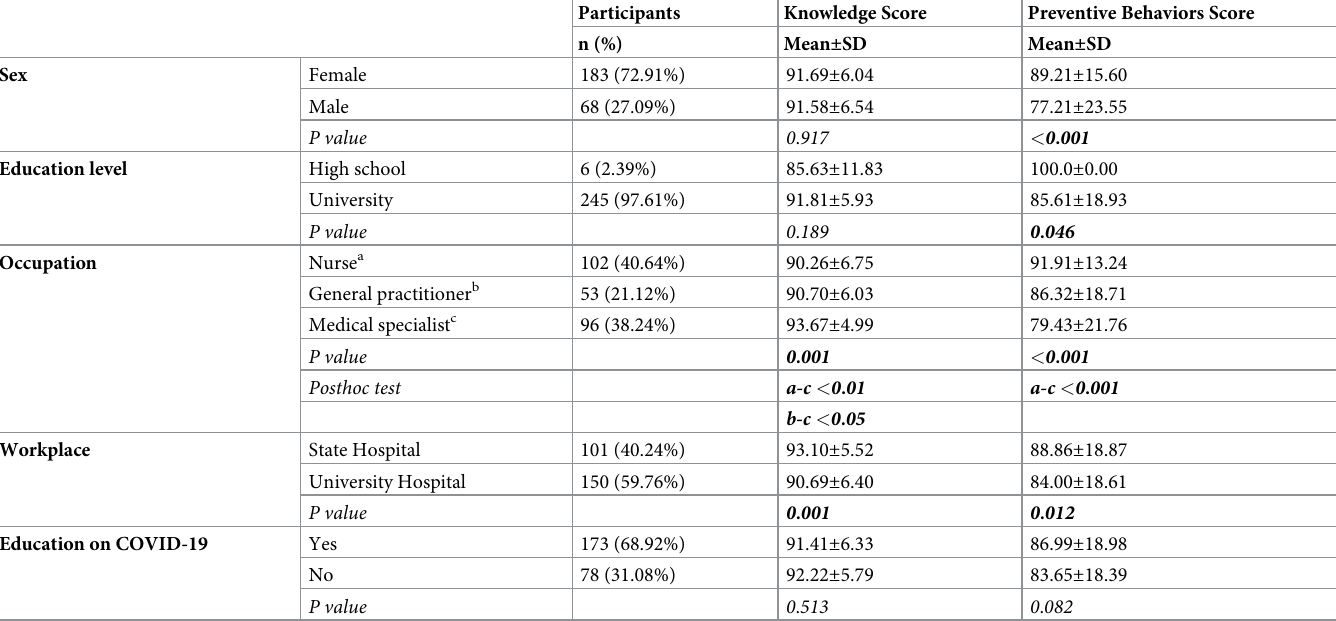
Table 1. Responses according to sociodemographic and working